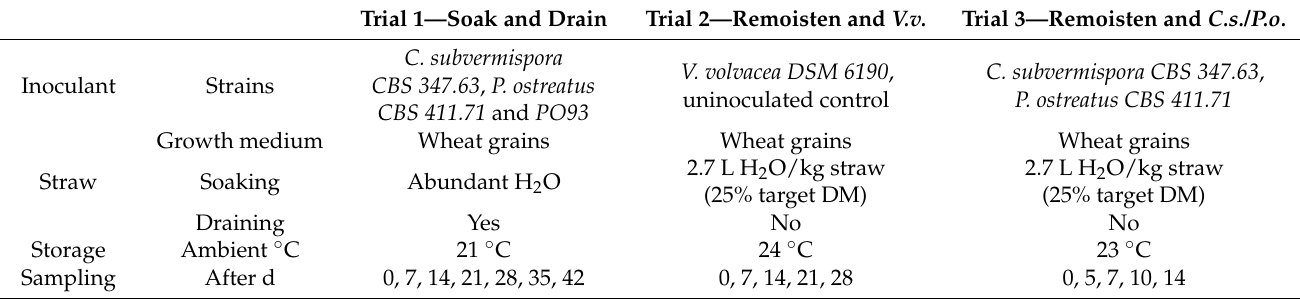
Table 1. Biological treatments in the different trials. Trial 1—Soak and Drain Trial 2—Remoisten and V.v. Trial 3—Remoisten and C.s. /